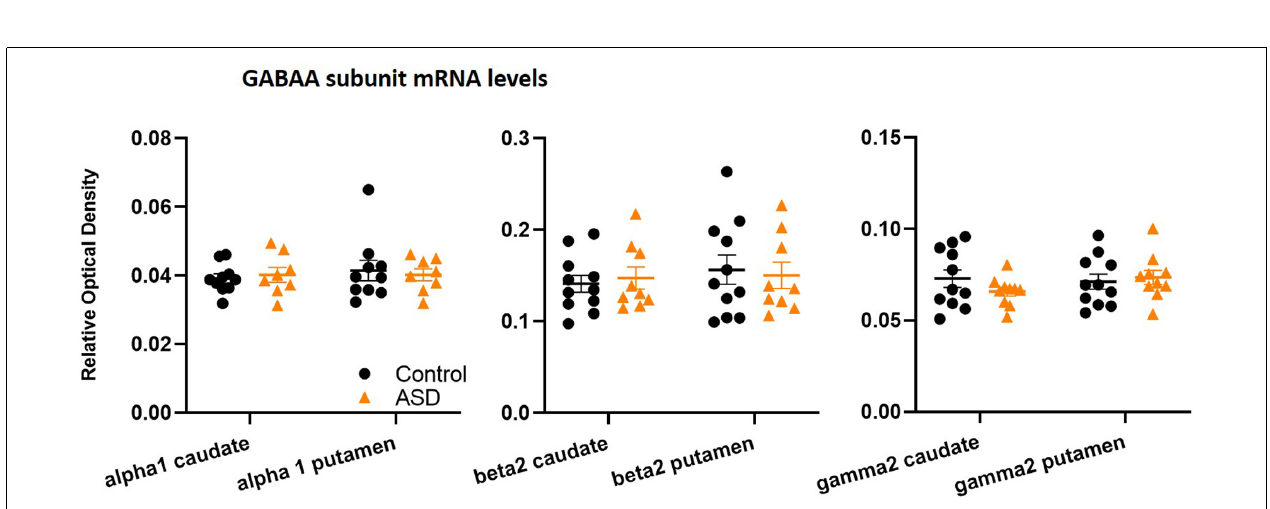
FIGURE 6 | GABA A subunit mRNA levels are unchanged between control and ASD cases, including α 1 ( n = 10 control, 8 ASD), β 2 ( n = 11 control, 9 ASD), and γ 2 ( n = 11 control, 10 ASD) in both caudate and